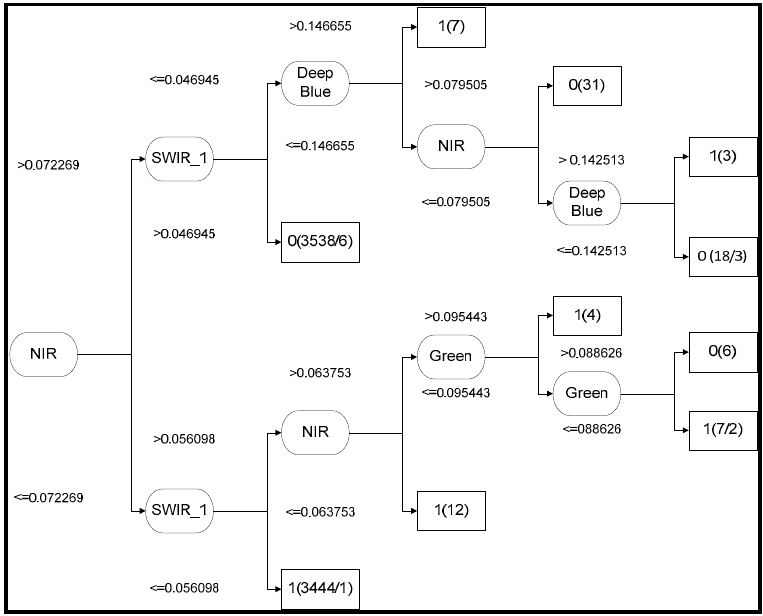
Figure 3. J48 decision tree model for water identification at the test site using OLI bands.